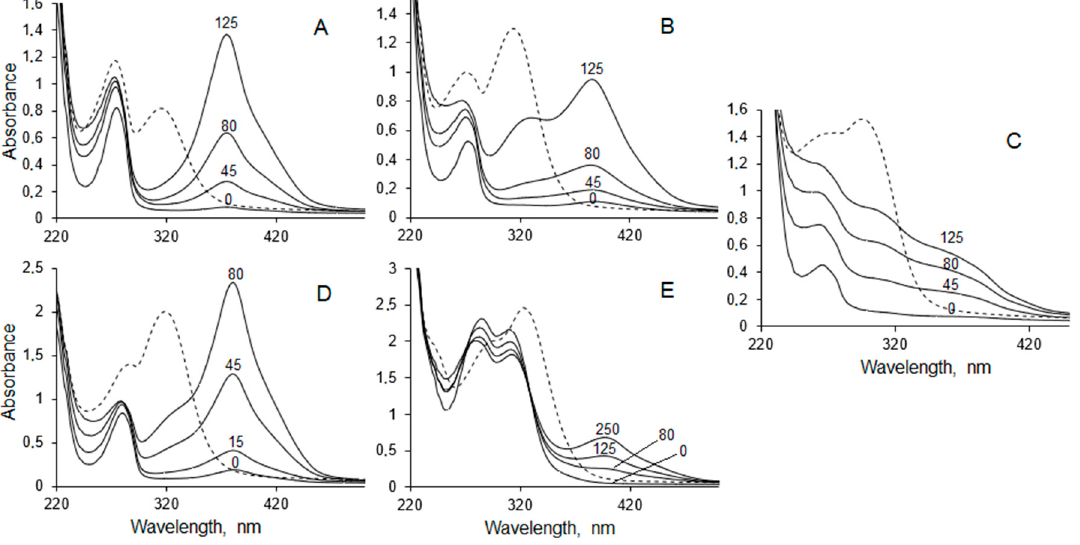
Figure 5. Biotransformations of pyrocatechol ( A ), 3-methylcatechol ( B ), 3-methoxycatechol ( C ), 4-methylcatechol ( D ), and caffeic acid ( E ) by whole cells of E. coli BL21 containing hcdB gene. Biotransformations were carried out in 50 mM potassium phosphate buffer pH 7.5 (solid line) at 30 °C with 0.5–1 mM of substrate. Incubation time is shown in min. Dashed lines indicate peak shifts to a shorter wavelength after acidification of reaction mixtures.